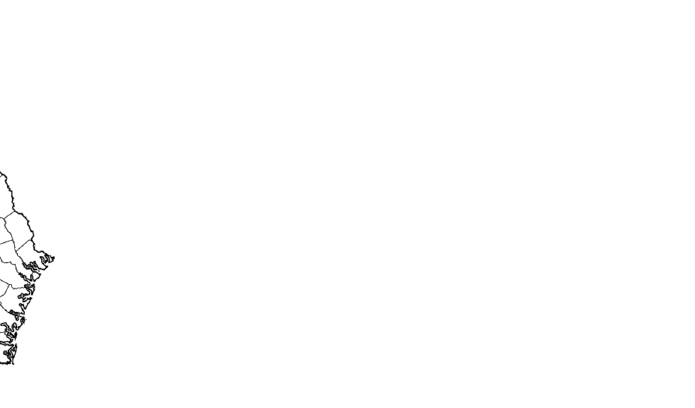
Figure 1. This map shows Walton County’s location in northeastern Georgia. (“Location of Walton Co., GA, within the U.S. State of Georgia”, by David Benbennick, Public Domain (https://en.wikipedia.org/wiki/Walton_County,_Georgia#/media/File:Map_of_Georgia_highlighting_Walton_County.svg, accessed on 7 August 2022.).